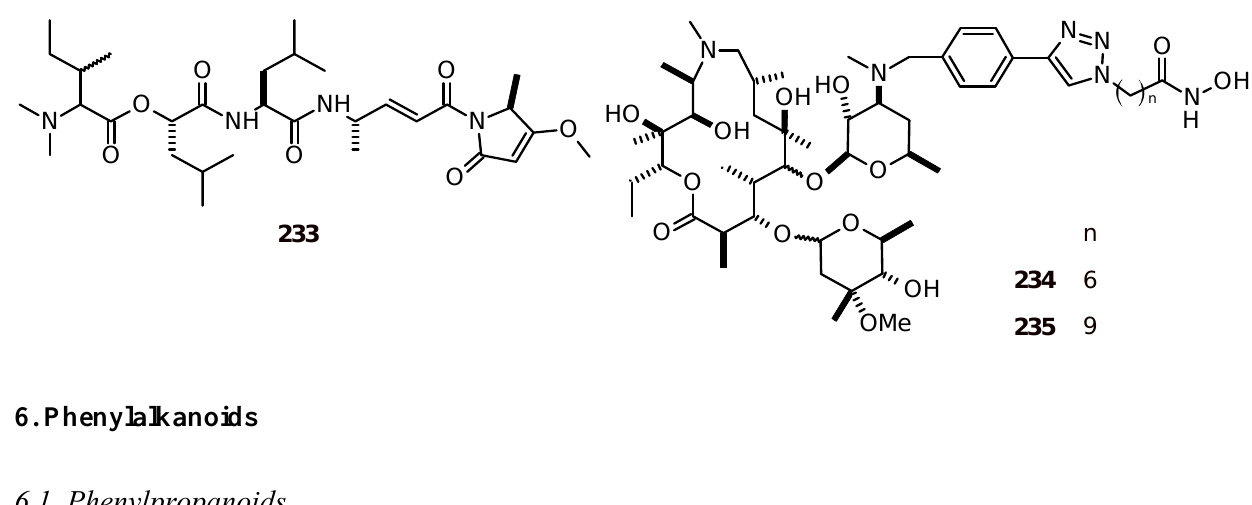
Figure 26. Structures of peptide and macrocyclic compounds 233 - 235